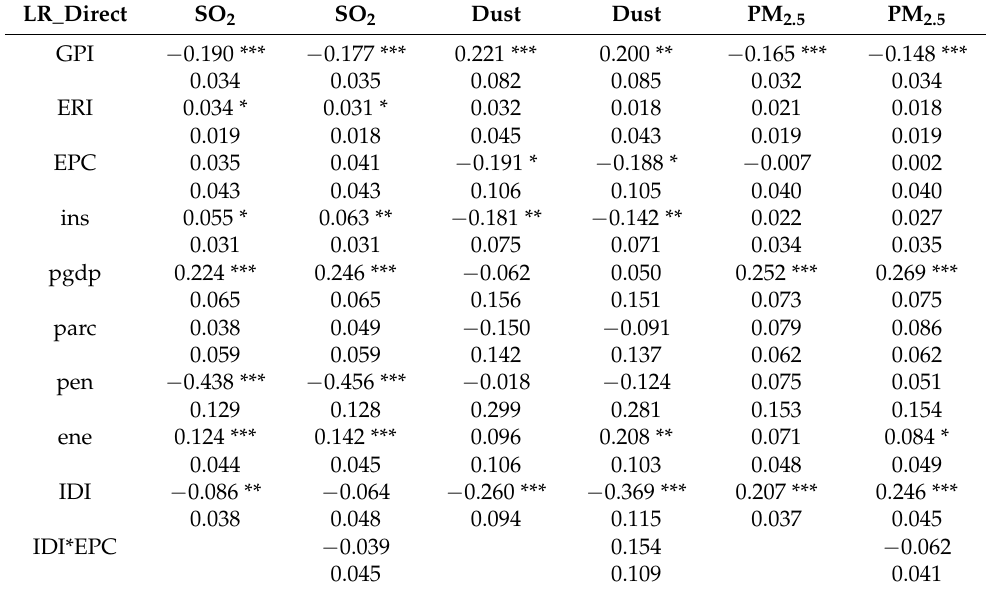
Table 6. Effect decomposition of the spatial Durbin